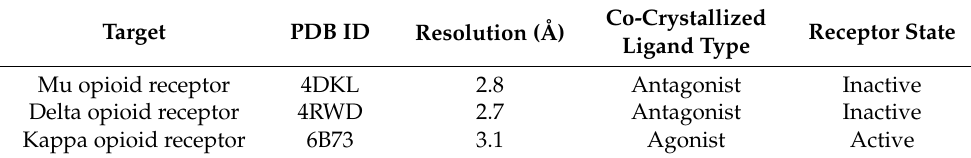
Table 1. The summary of the crystal structures of opioid receptors used in the study.